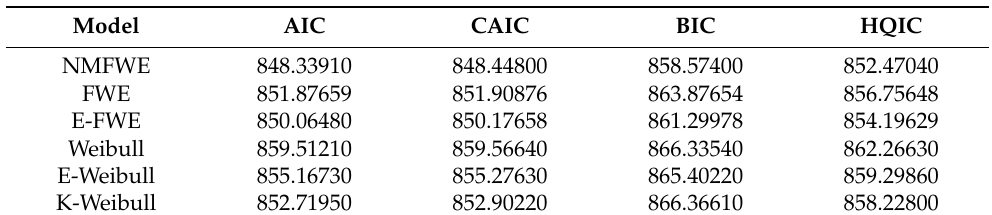
Table 8. The values of AIC, CAIC, BIC, and HQIC of the fitted models, using the second COVID-19 dataset.